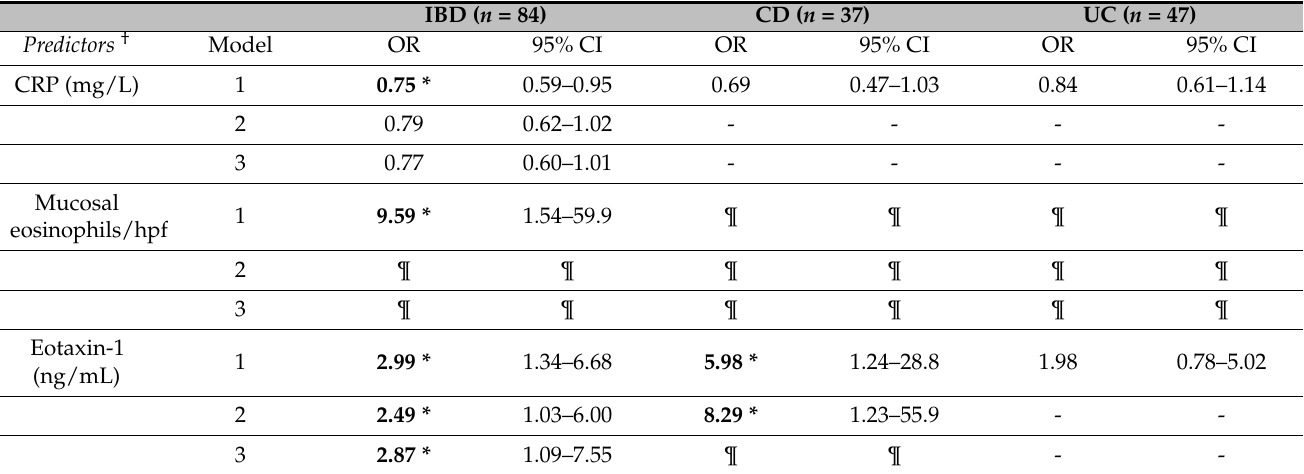
Table 3. Multivariable logistic regression analysis of serum CRP, eotaxin-1 and mucosal eosinophil counts as predictors of clinical response or remission to vedolizumab induction therapy at week 14 of patients from the discovery cohort. Adjusted odds ratios (ORs) (with 95% CI) were calculated for all IBD patients, and for CD and UC cohorts